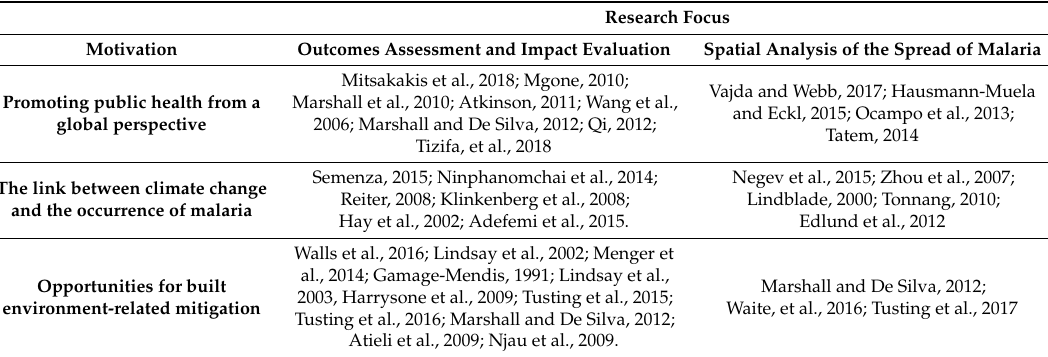
Table 2. Analysis of closely related